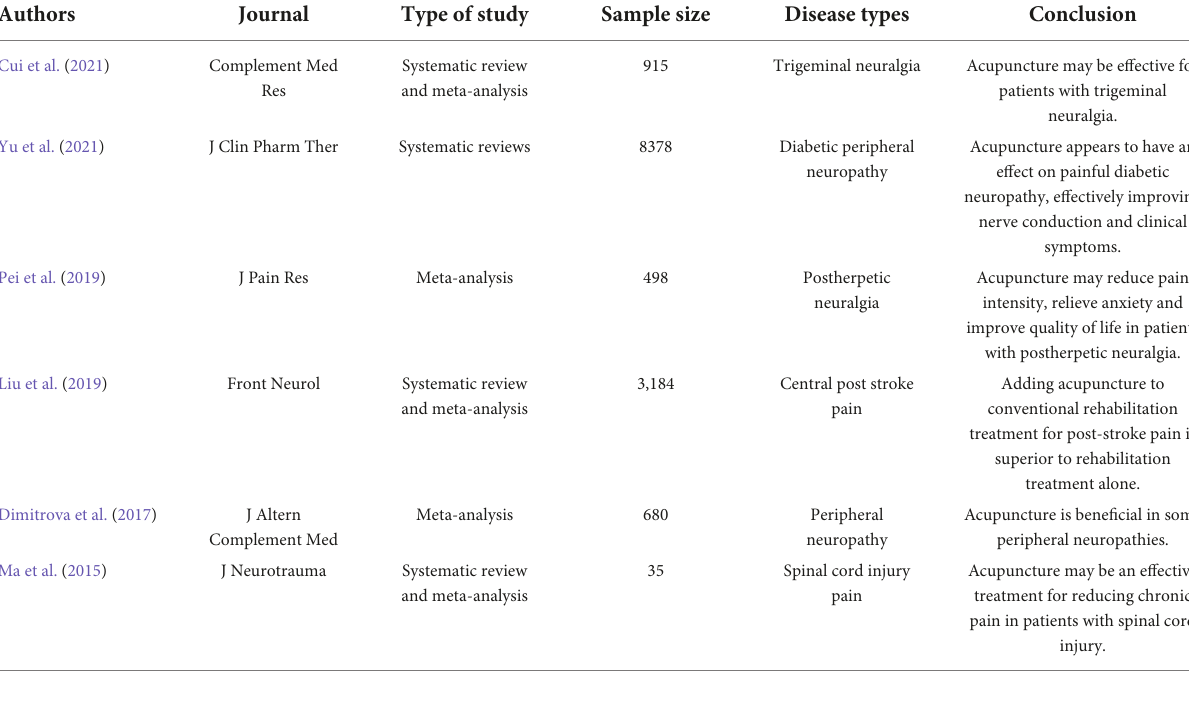
TABLE 3 Animal models of neuropathic